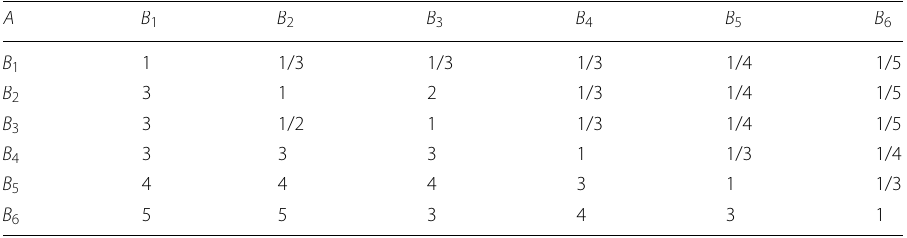
Table 1 AHP judgment matrix